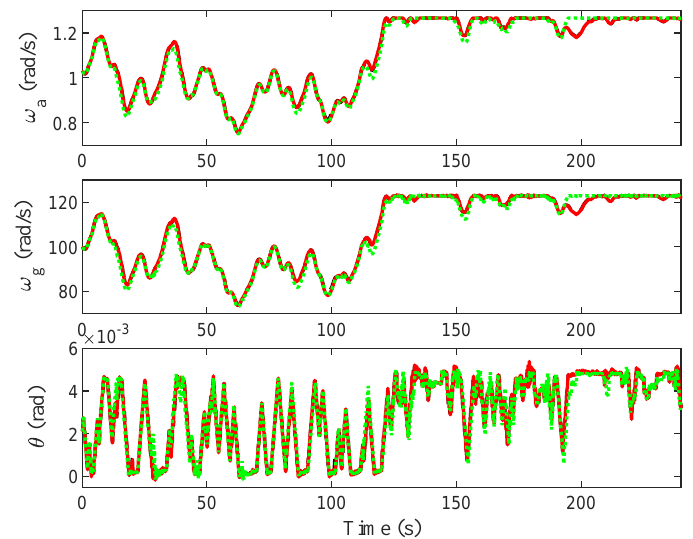
Figure 12. States ω a , ω g and θ for the proposed EMPC 1 (black dash-dotted line), EMPC 2 (red solid line) and classical tracking MPC (green dashed line) under turbulent wind.